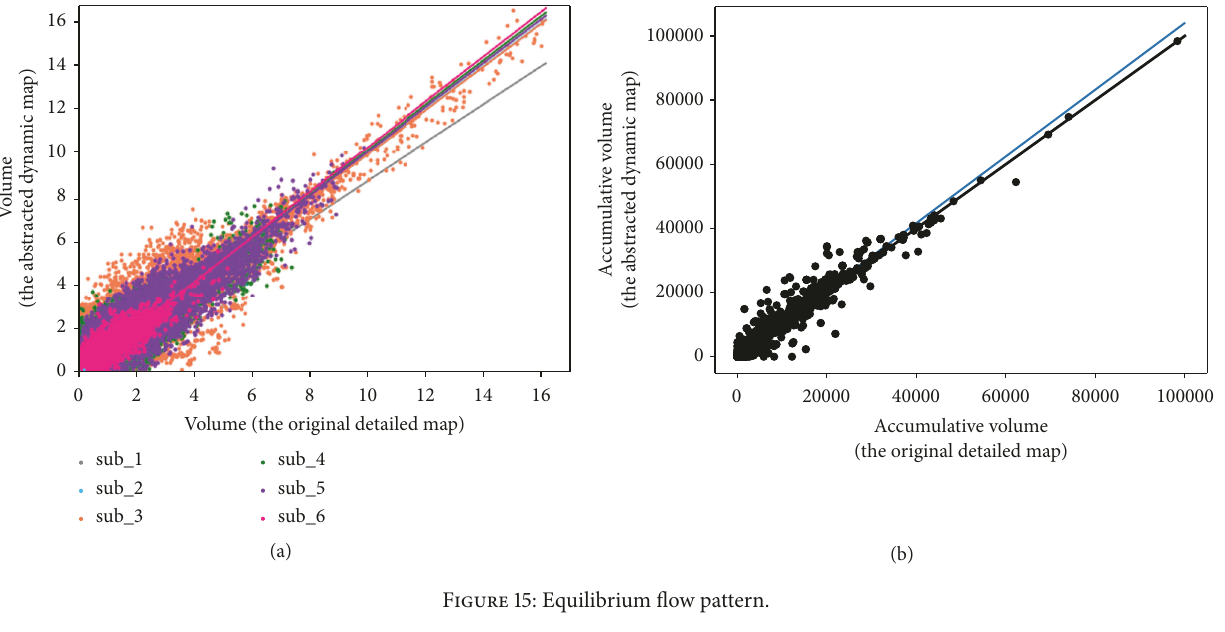
Figure 15: Equilibrium flow